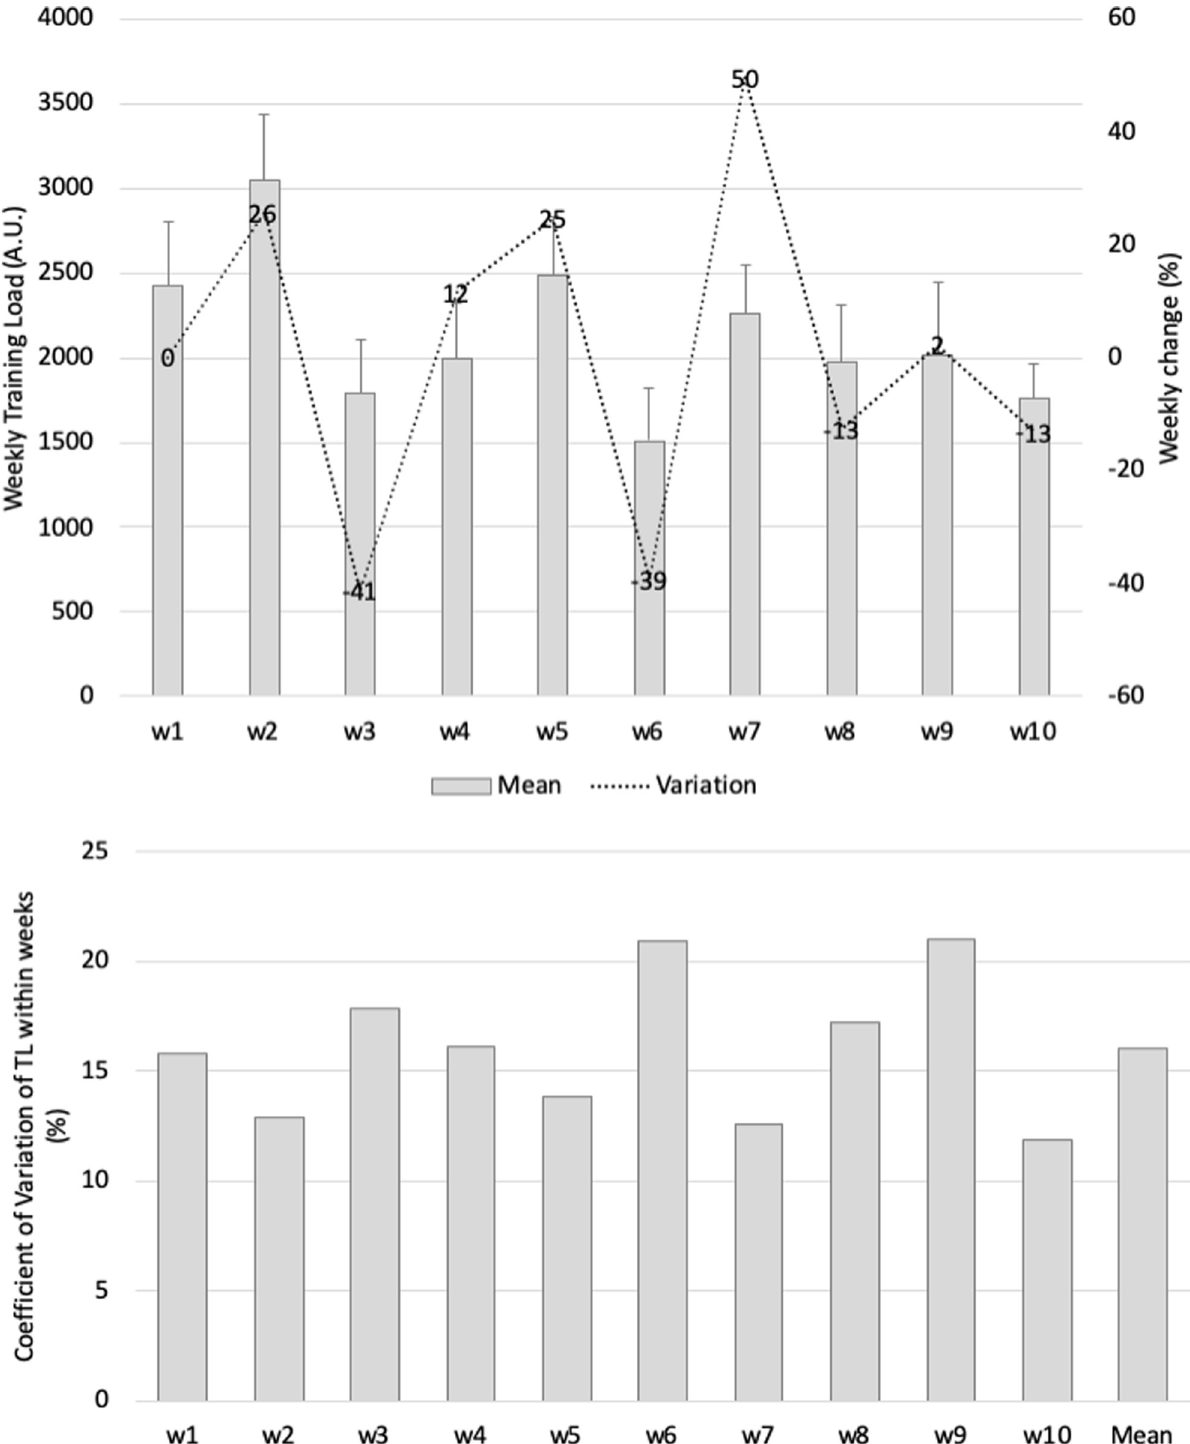
Fig 1. (a) Mean (SD) and weekly changes (%) in weekly training load over 10 weeks and (b) within-week load variations (CV%) and between weekly load variations (CV%).